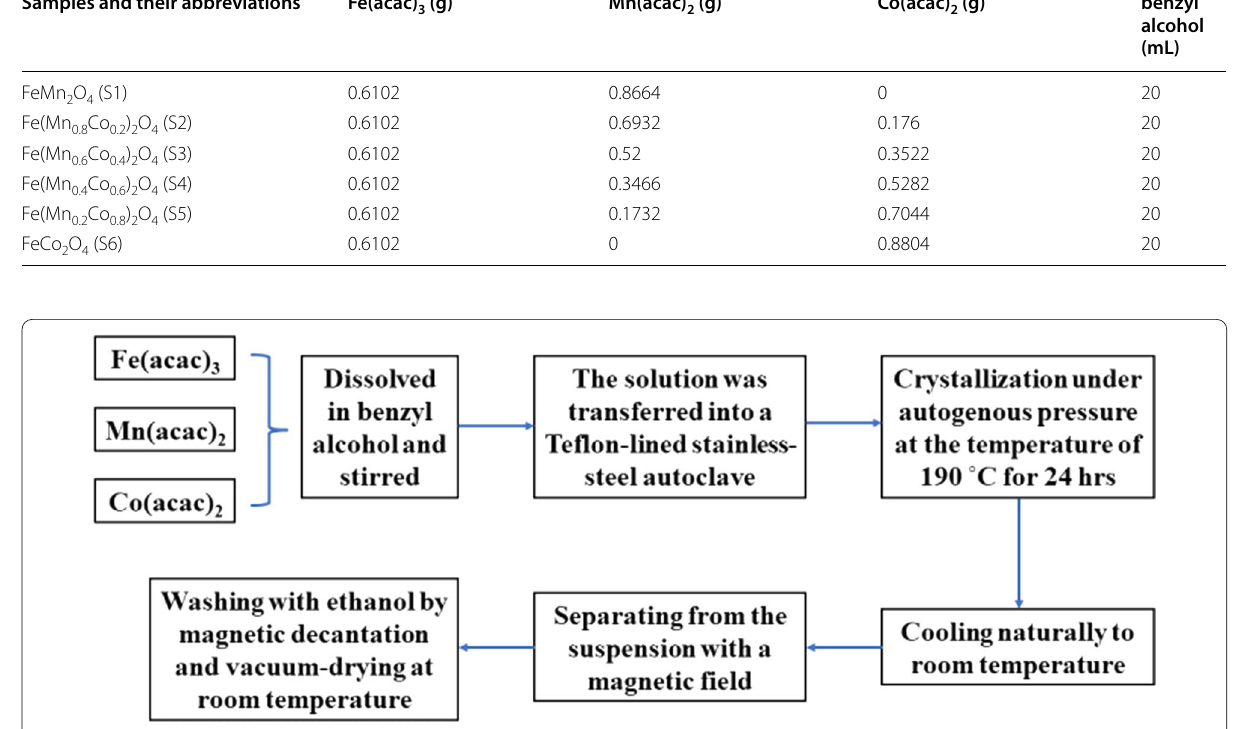
Table 1 Composition, abbreviations of the sample names, and quantities of reagents required for the synthesis of the samples Samples and their